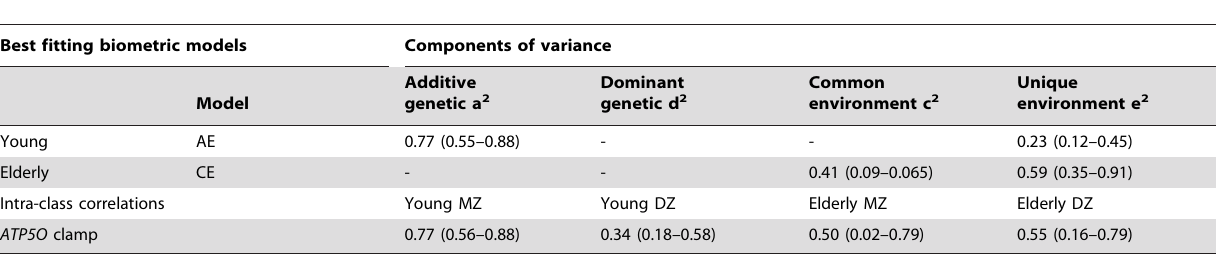
Table 2. Heritability of ATP5O mRNA expression in skeletal muscle from 86 young and 69 elderly twins during clamp.